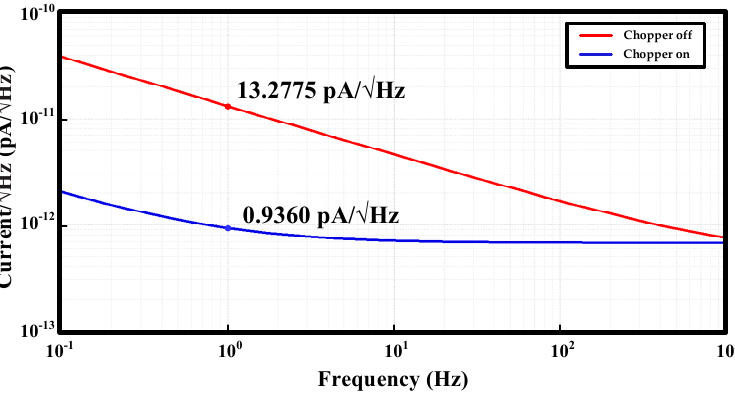
Figure 13. Input-referred noise simulation results of the readout circuit. Table 1 shows noise contributors of readout circuit. When the chopper is disabled, the flicker noise components in the current mirror, M 1,2 , form about 72% of the total noise. When the chopper is enabled, the main contributors are changed to the thermal noise of M 1,2 . Table 1. Simulated noise contributors.